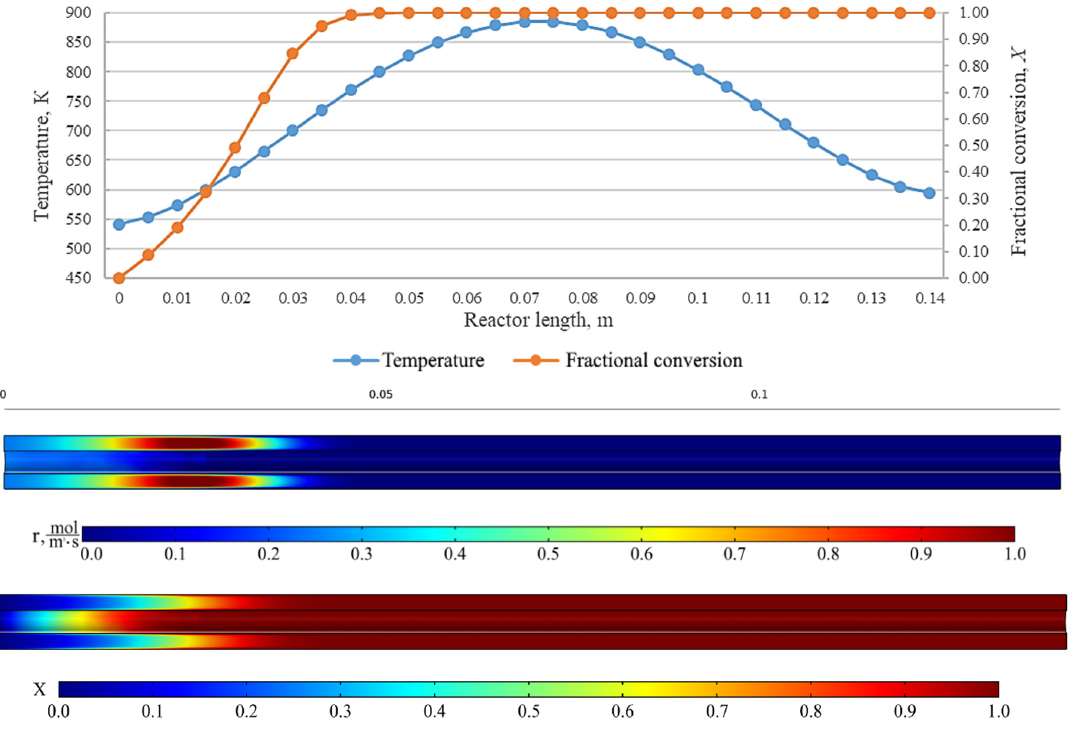
Figure 12. From top to bottom: temperature and fractional conversion curves, profiles of the reaction rate and fractional conversion along the reactor length for the experiment BnOm_600_23 (Tmax = 600 °С , 𝑉(cid:4662) = 0.05 L/min).